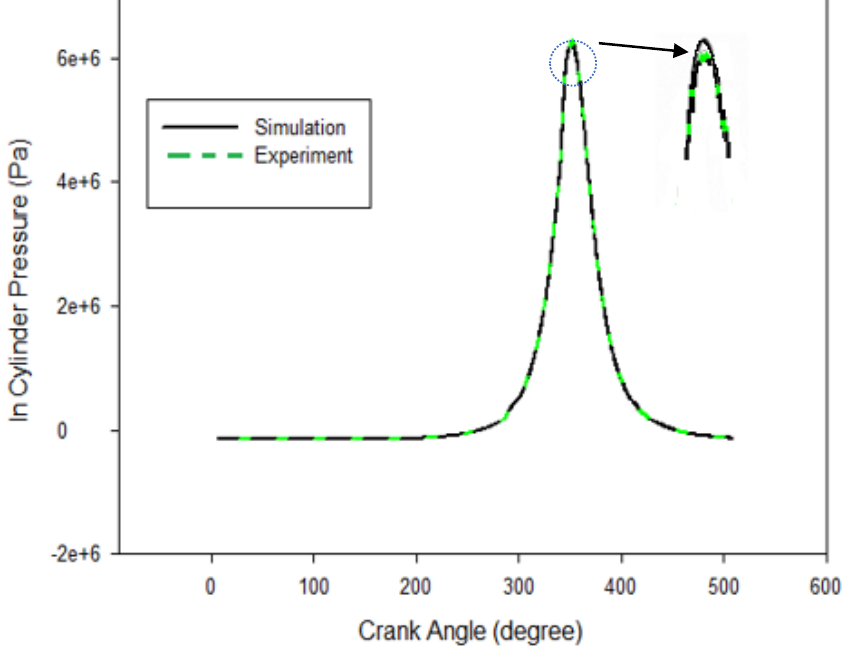
Figure 7. The plot of the in-cylinder pressure (Pa) against the crank angle (degree). Table 3. Grid independence